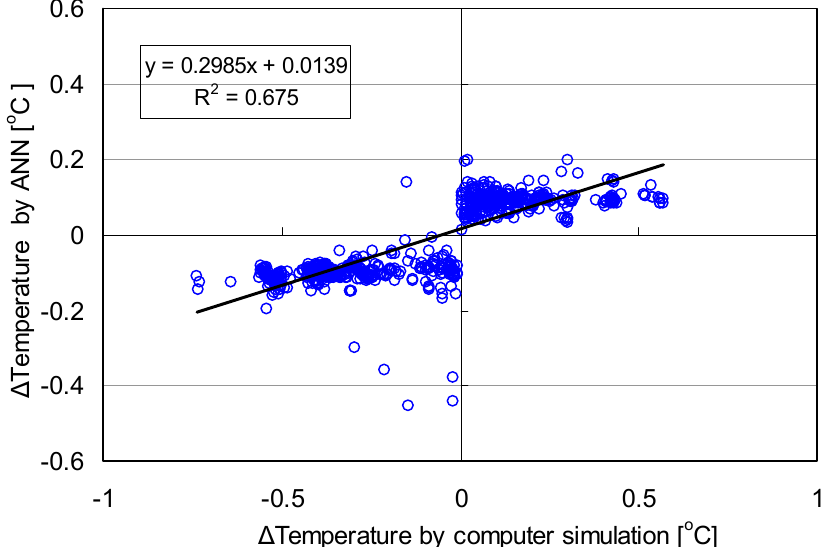
Figure 7. Relationship of Δ Temperature between computer simulation and ANN